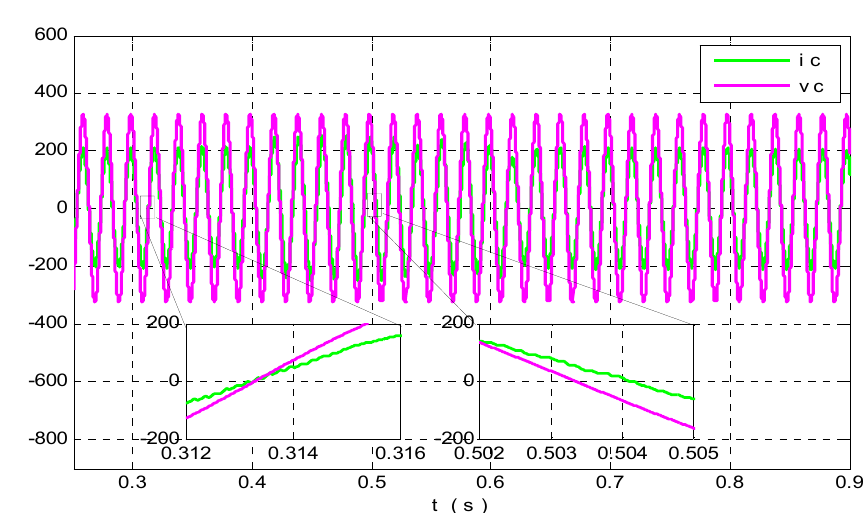
Figure 21. Voltage and current signals (phase b).